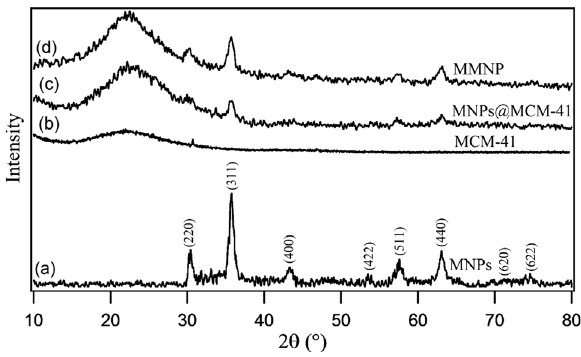
Figure 3: Low angle XRD pattern of: (a) MCM-41, (b) MNPs@ MCM-41, and (c) MMNP.